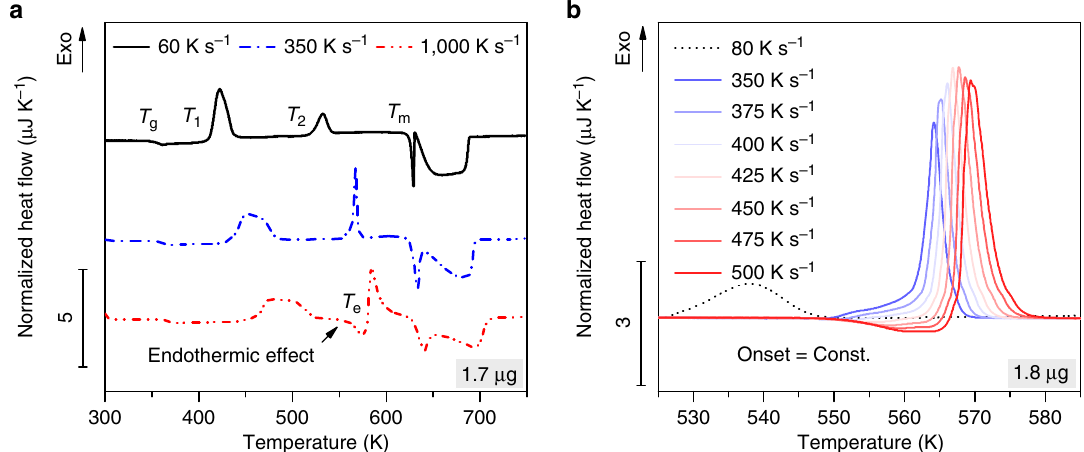
Figure 1 | Heating of Au 70 Cu 5.5 Ag 7.5 Si 17 . ( a ) FDSC heat flow curves normalized to the heating rate. At low rates, a glass transition ( T g ), exothermic phase transition peaks ( T 1 and T 2 ) and endothermic melting ( T m ) can be seen. The phase transition temperatures T 1 and T 2 shift to higher temperatures with increasing heating rate, and at sufficiently high rates an unexpected endothermic peak (at T e ) arises after T 1 and just before T 2 . ( b ) Close-up of the start of the endothermic effect and the second exothermic peak ( T 2 ). The onset of the endothermic effect shows no rate dependence, which indicates melting, whereas the T 2 peak shifts to higher temperatures with increasing rates and changes its shape and size if located above T